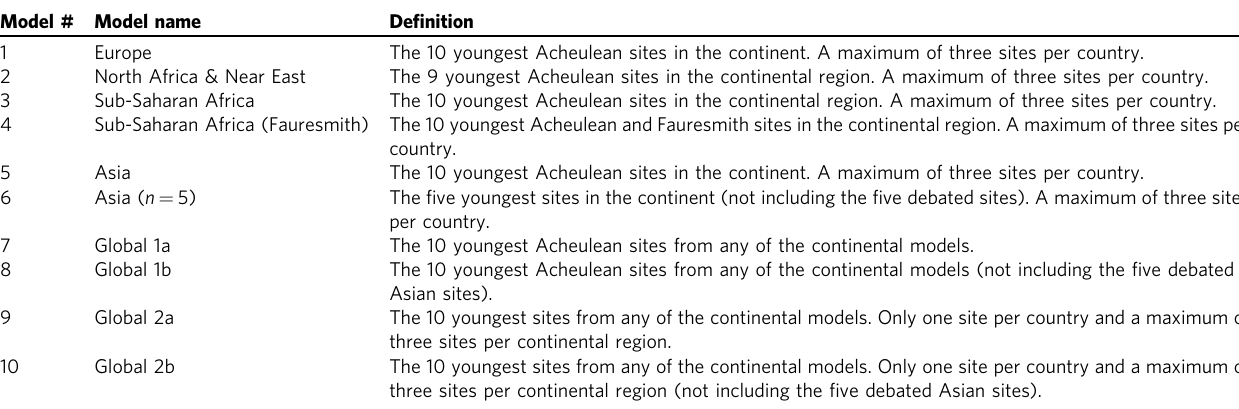
Table 1 De fi nitions used in the 10 Acheulean extinction